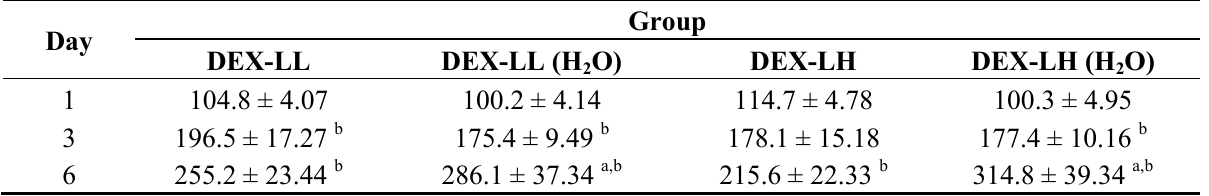
Table 4. Fed serum glucose (mg/dL) of the experimental groups on days 1, 3 and 6 of the study.